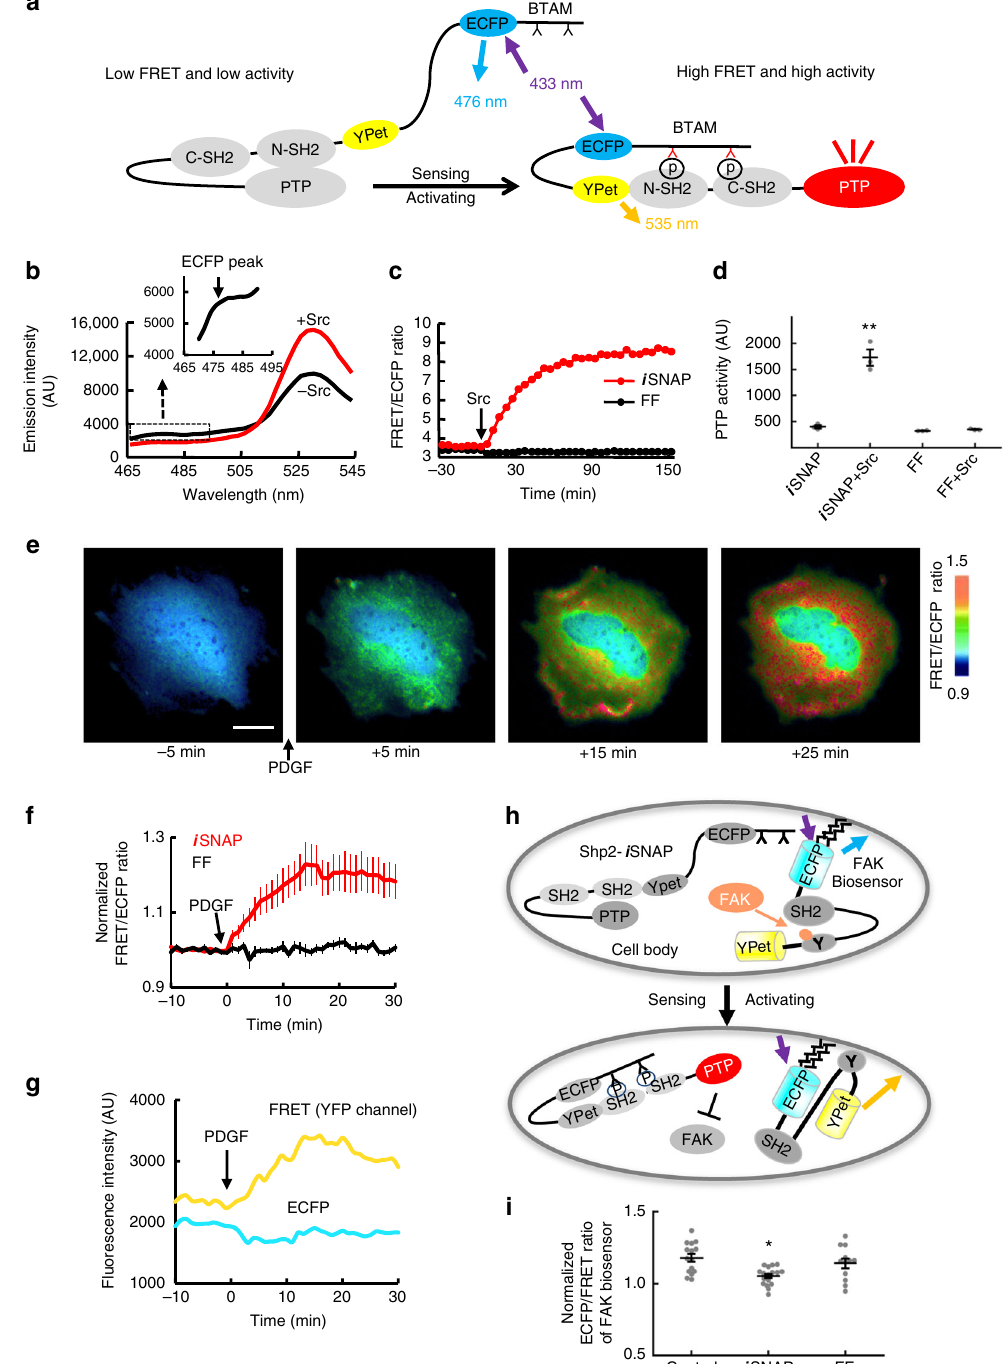
Fig. 1 The design and characterization of the Shp2- i SNAP in vitro and in cells. a Schematic representation of the drawing of Shp2- i SNAP displaying a FRET increase and an activated PTP ( red ) after a conformational change induced by phosphorylation (P). b The emission spectrum change of the Shp2- i SNAP before ( black ) and after ( red ) Src kinase incubation in vitro. The inset shows the ECFP peak of the Shp2- i SNAP spectrum before kinase incubation. c , d The emission ratio time courses c and phosphatase activities d of Shp2- i SNAP and its FF mutant before and after Src incubation in vitro ( n = 3, 3, 3, 3). e The ratiometric images of a MEF cell transfected with the Shp2- i SNAP before and after PDGF stimulation at indicated time points. All color scale bars in fi gures represent the FRET/ECFP emission ratio. Scale bars , 20 μ m. f The ratio time courses (mean ± s.e.m.) of MEFs expressing the Shp2- i SNAP ( n = 10) or its FF mutants ( n = 7). g The time course of FRET and ECFP fl uorescence intensities of one cell from f . A clear increase of FRET (YFP channel) and a concomitant decrease of ECFP intensity indicates FRET ef fi ciency increase after PDGF addition. h Schematic drawing of the inhibitory effect of the activated non- fl uorescent Shp2- i SNAP on FAK monitored by a membrane-bound FAK biosensor. The activated FAK and Shp2- i SNAP are colored in orange and red, respectively. i Dot plot of FAK biosensor emission ratios (mean ± s.e.m.) in PDGF-stimulated MEFs expressing control vector, the Shp2- i SNAP, or its FF mutant ( n = 15, 17, 12). * P < 0.05. ** P < 0.01 (two-sided Mann – Whitney U -test adjusted for multiple group